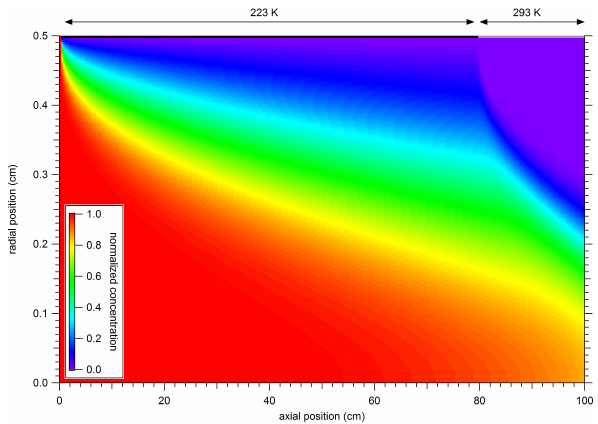
Figure 1. Simulated transmission of dimers through the CIMS sam- pling line at a temperature of 223K for the incoming air. The tem- perature of the sampling line is fixed to 223K for the first 80cm (black line along top axis) and to 293K for the last 20cm (grey line along top axis). Wall loss is the dominant loss process over the first 80cm, whereas evaporation is an additional loss process for the last 20cm. The overall transmission (diffusion loss and evaporation) is 22.8% at a flow rate of 7.6Lmin − 1 , while it is 47.5% when evap- oration is neglected (diffusion loss only). See text for